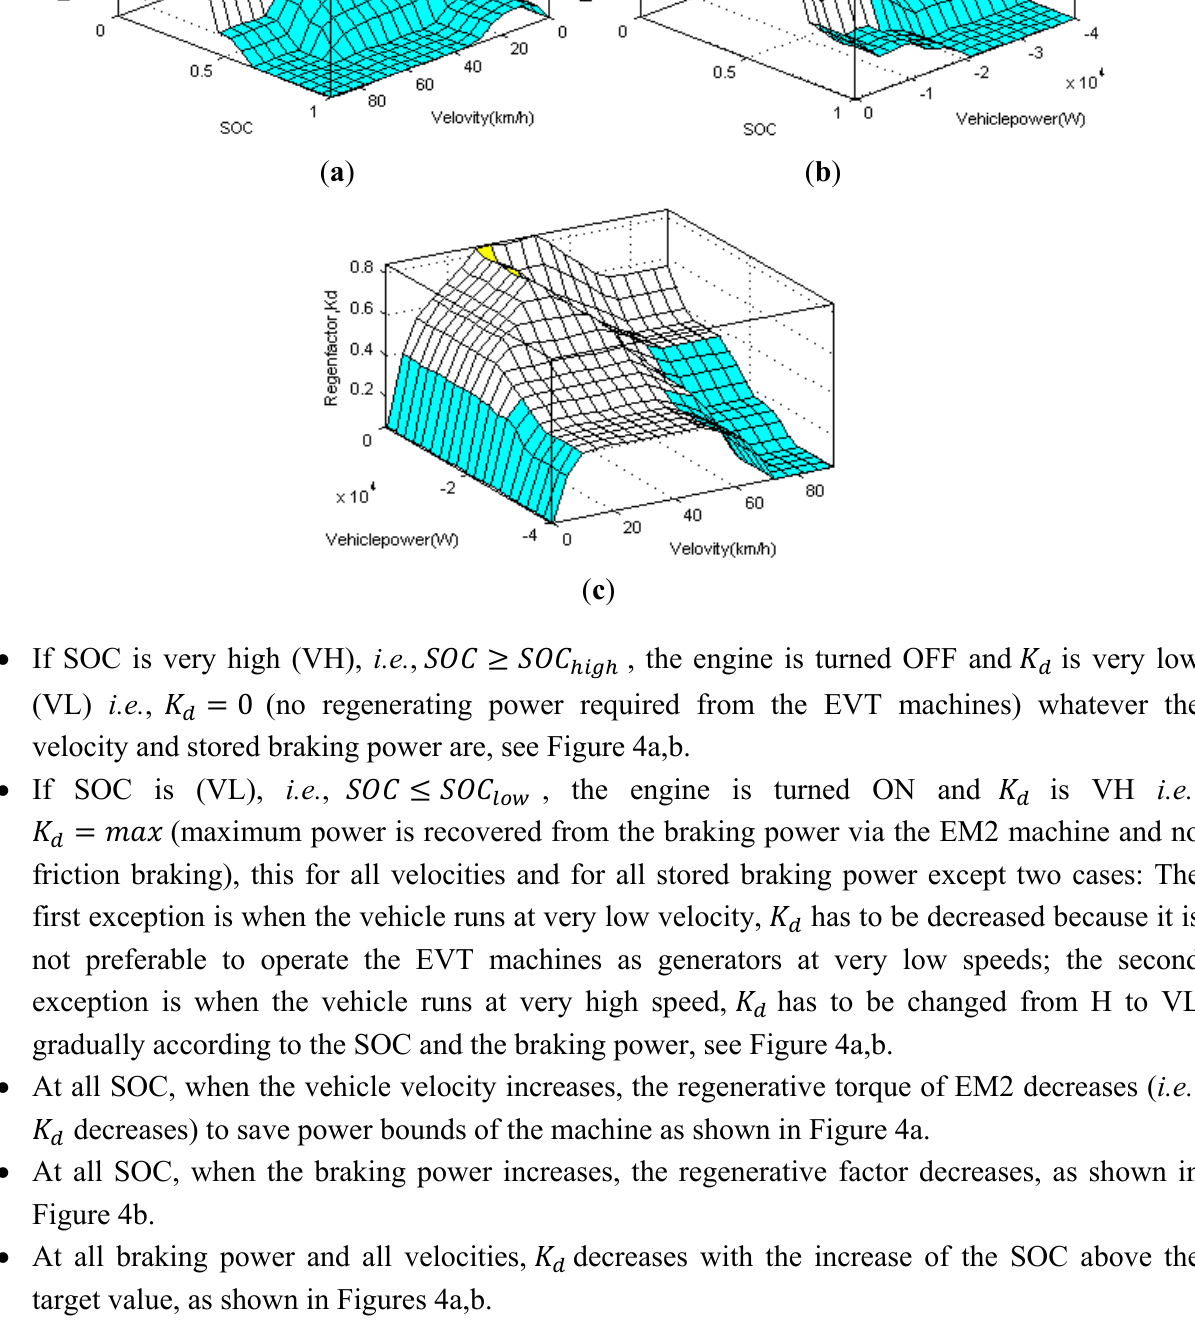
; ( c ) Effect of vehicle power (cid:3031)